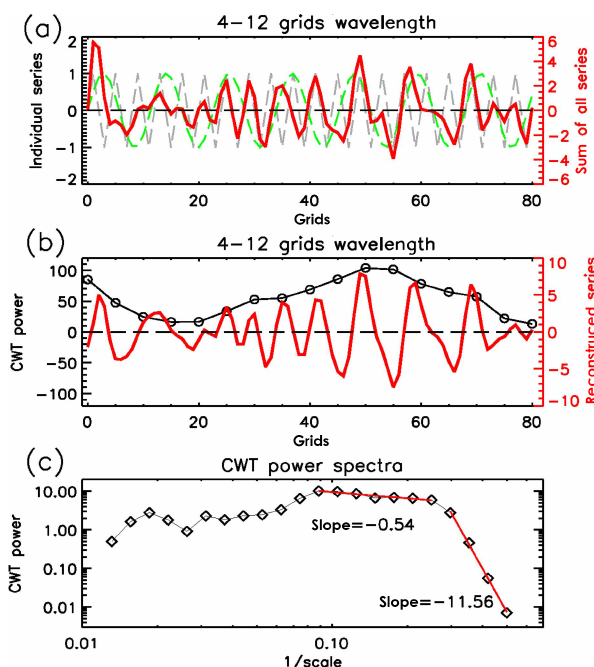
Figure 1. Demonstration of the continuous wavelet transform (CWT) applied to an artificially created series. (a) The created se- ries (red line) consisting of seven sinusoidal components with wave- lengths (or scales) of 4.0, 4.7, 5.6, 6.7, 9.5, and 11.3 grid units, each of them with the same amplitude of 1.0. The gray and green dashed lines are for the scales of 4.0 and 11.3 grids, respectively, serving to demonstrate the individual series. Note that the red curve has used the scale on the right axis which corresponds to a 3-times-larger magnitude. (b) The total CWT power series (black with circles) and the reconstructed series (red line) using the wavelet coefficients and components. (c) The CWT power spectra. The slopes (i.e., red lines) are calculated over the seven scales used to create the series and the smaller scales that are present due to the non-orthogonal basis in the CWT